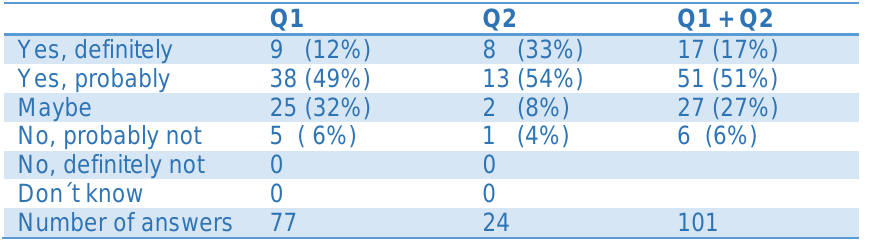
Table 6: Statement. Cost overruns would be considerably less if the client puts more resources into evaluation of risks early in the